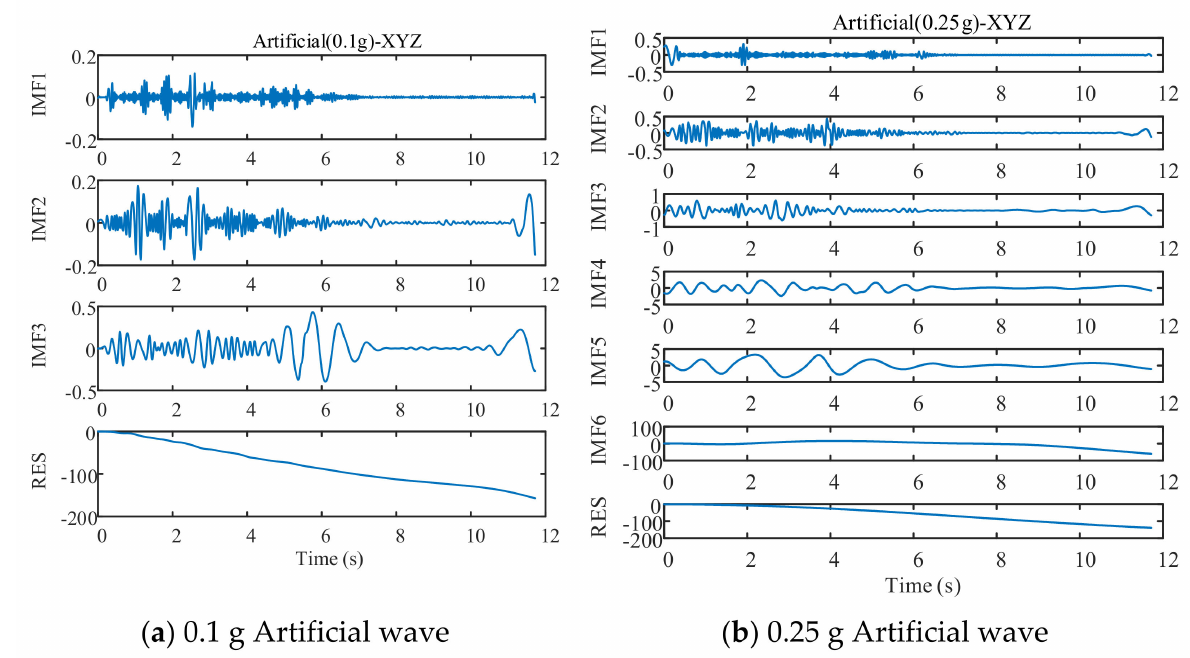
Figure 10. EMD decomposition of Artificial